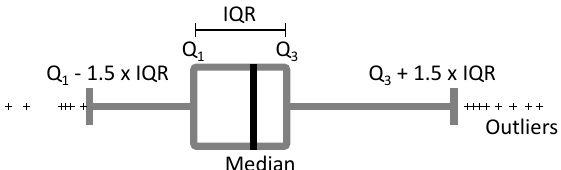
Figure 6. The left and right sides are the first and third quartiles (respectively Q 1 and Q 3 ). The line inside the box represents the median. The reach of the whiskers past the first and third quartiles is 1.5 times the Interquartile Range (IQR). The crosses represent the outliers lying beyond the whiskers.